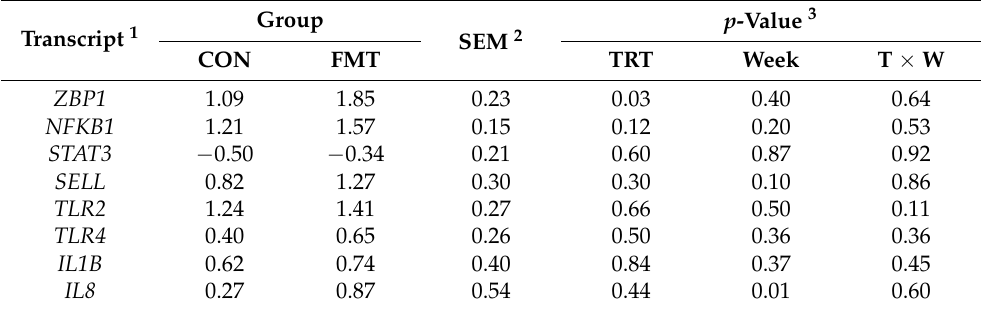
Table 5. Gene expression in polymorphonuclear leukocytes (PMNL) during the neonatal period (from birth to 3 week of age) in Holstein dairy calves raised under a conventional nutritional program (CON) or subjected to fecal microbiota transplantation